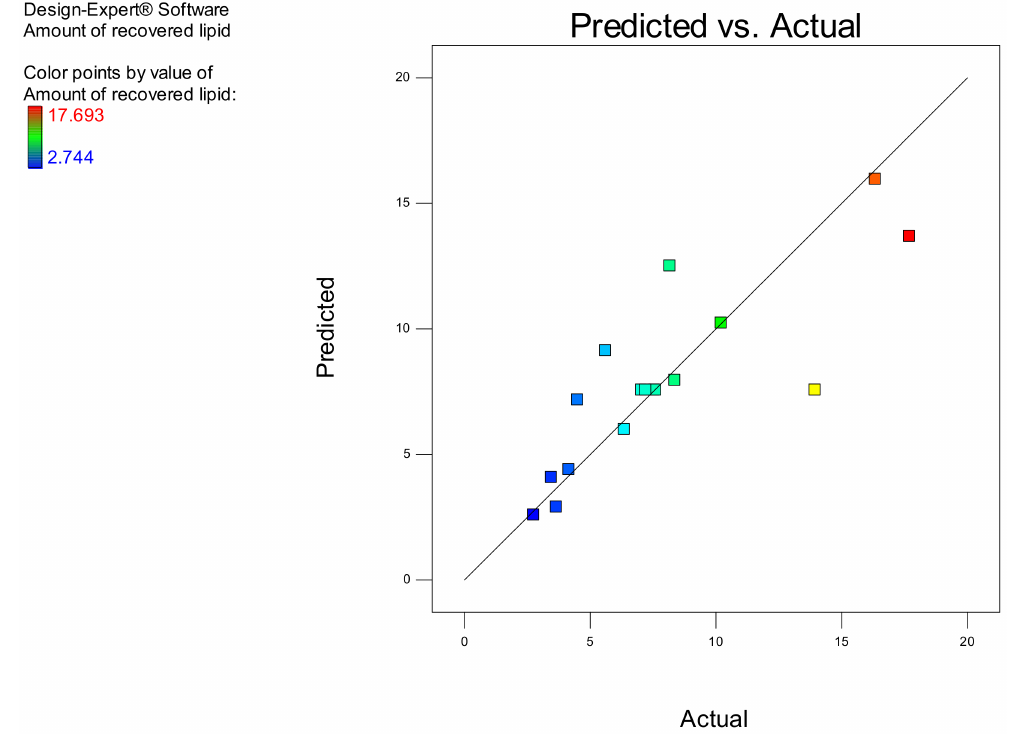
Figure 2. Predicted vs. actual